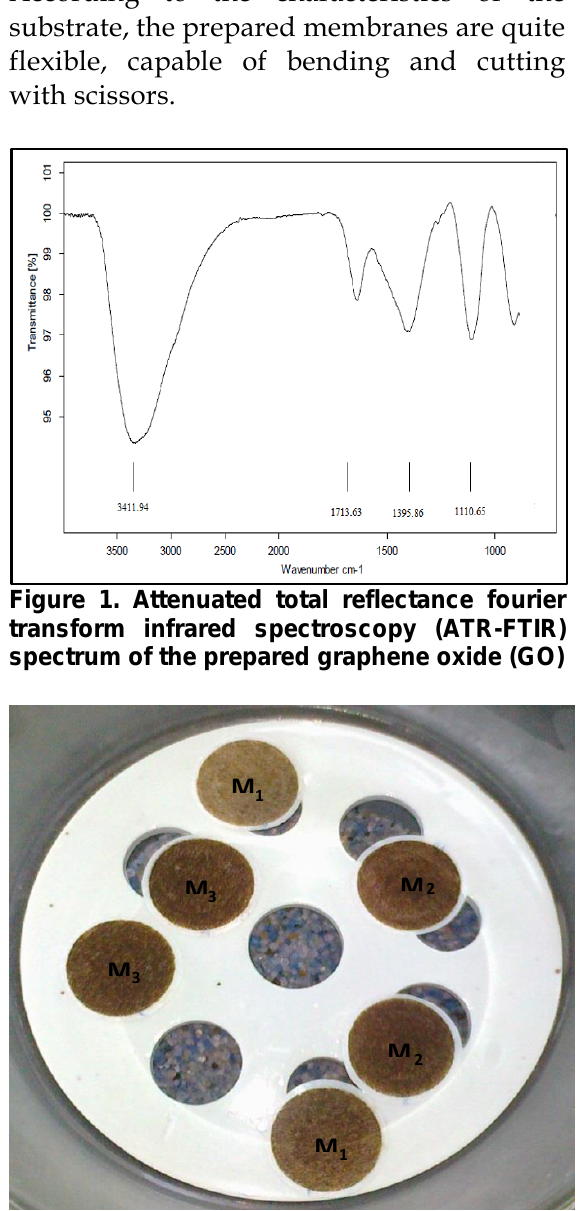
Figure 2. Digital photograph of graphene oxide-coated